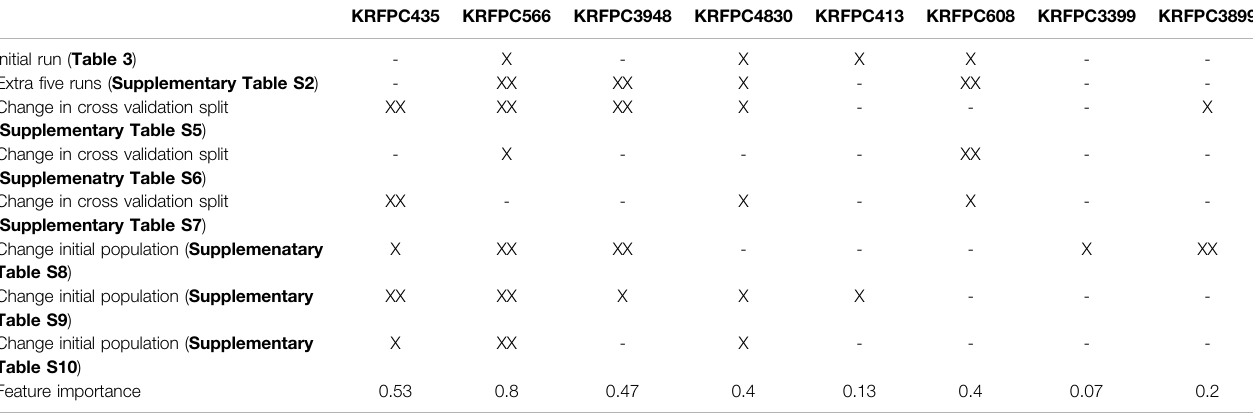
TABLE 5 | Analysis of the repeated features over different runs. The column headers display each of the features that appear in Table 4 . The rows contain information on whether these features were present or not in each of the performed runs: XX indicates that the feature was repeated across common sets of features, and X indicates the presence of the feature in only one common set.